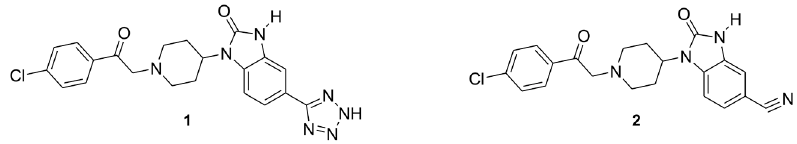
Figure 1. Structures of the 1,3-dihydro-2 H -benzimidazol-2-oxo-derivatives which were screened using the radio immune assay (RIA) and HPLC-FL method.